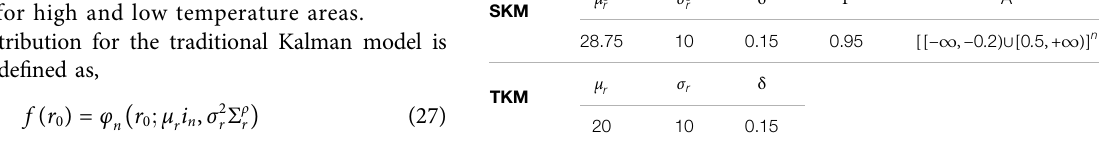
TABLE1| Parameter valuesfortheselectionGaussianinitialmodel(SKM)andthe Gaussian initial model (TKM).